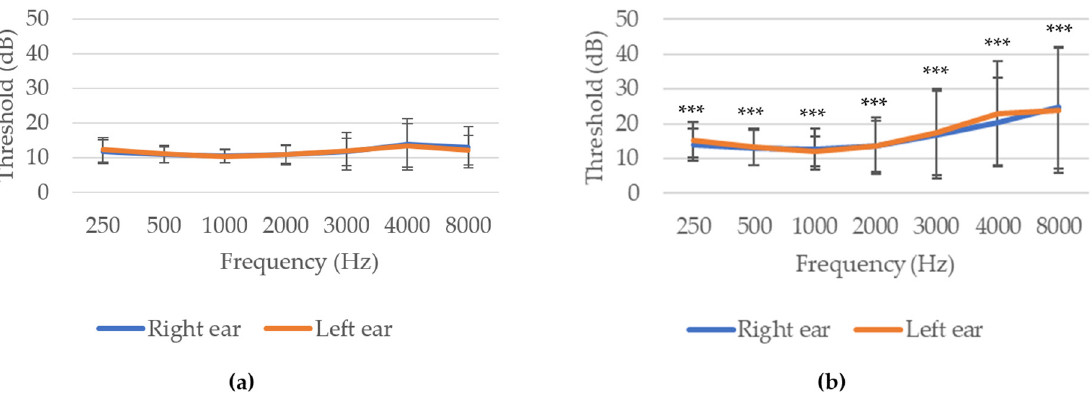
HL was greater at higher frequencies (Figure 4).